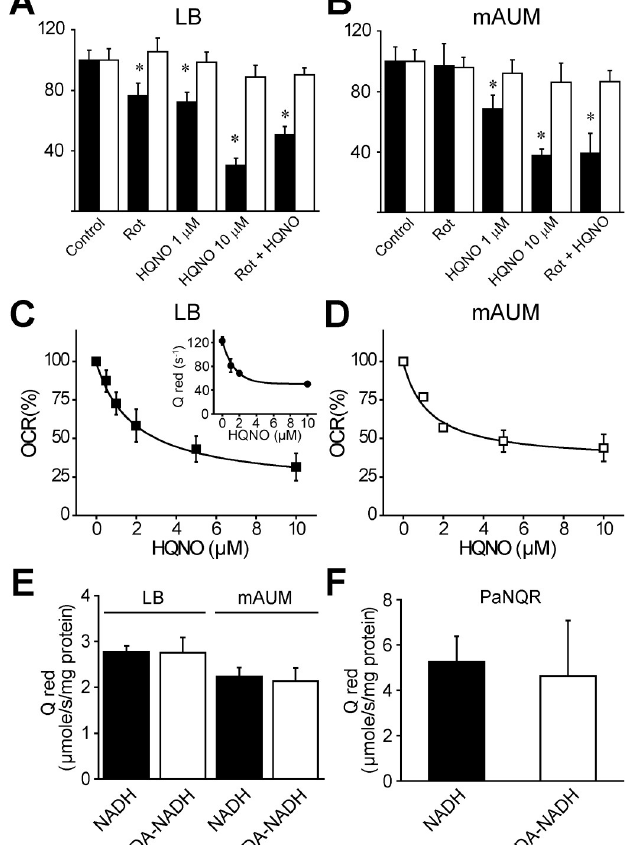
Fig 6. NQR activity measurements in LB and mAUM membranes. NADH-dependent (black) and Succinate- dependent respiratory activity of LB (A) or mAUM (B) membranes in the presence of rotenone (1 μ M) or HQNO (1 or 10 μ M). Bars represent mean ± S.D. n � 3. � , p < 0.05 after t test between NADH-dependent (black) or Succinate- dependent (white) respiratory activity. Effect of HQNO on the NADH-dependent rate of oxygen consumption in LB (C) and mAUM membranes (B). Inset in C, HQNO titration on the activity of the purified Pa-NQR. Inset data were taken from reference [24]. Ubiquinone reductase activity of solubilized membranes obtained from cells grown in LB or mAUM (E) or purified P . aeruginosa NQR (F) using as substrates NADH (black) or deamino NADH (white; DA-NADH). Data are expressed as SDM (n � 5). � p < 0.05 vs